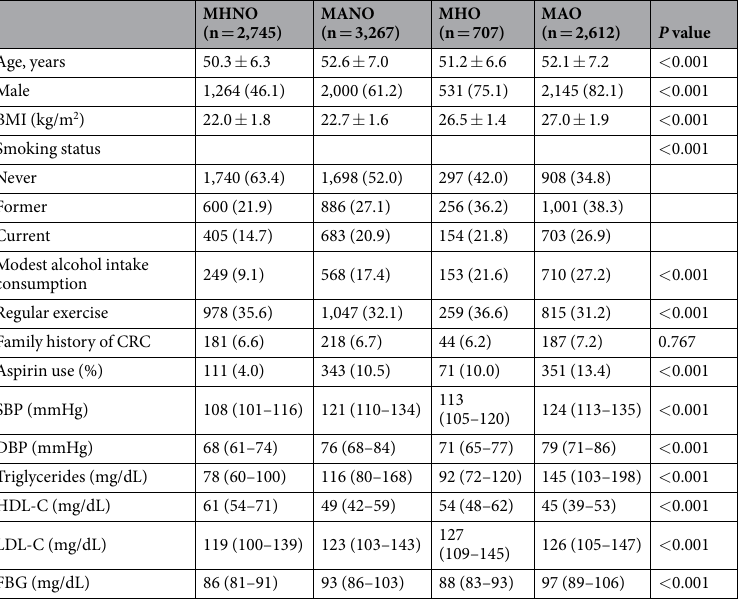
Table 1. Baseline characteristics of study participants by obesity and metabolic status. Values are expressed as means ± standard deviation, percentages, or median (interquartile range). a High risk adenoma includes any adenoma larger than 1 cm, 3 or more adenomas, any adenoma with a villous component, or high-grade dysplasia. MHNO, metabolically healthy non-obese; MANO, metabolically abnormal non-obese; MHO, metabolically healthy obese; MAO, metabolically abnormal obese; BMI, body mass index; CRC, colorectal cancer; SBP, systolic blood pressure; DBP, diastolic blood pressure; HDL-C, high-density lipoprotein